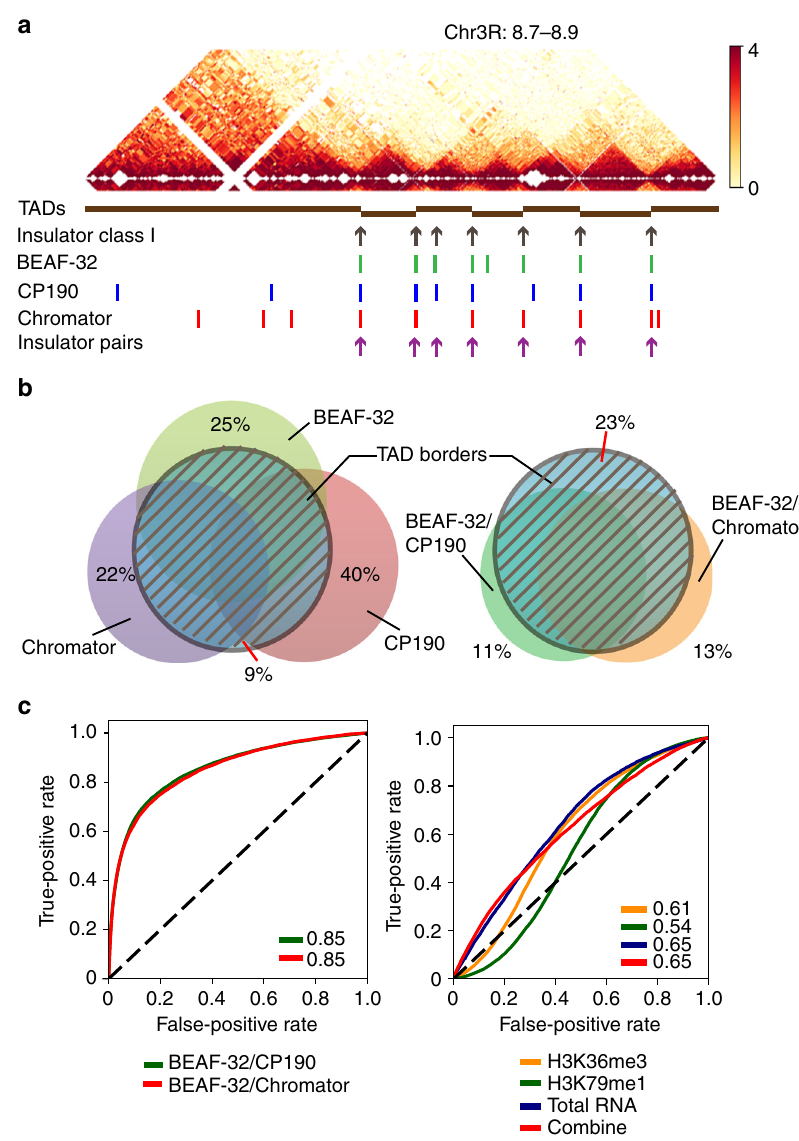
Fig. 2 The TADs are demarcated by pairs of insulator proteins. a The locations of known Drosophila insulator proteins, together with the TADs identi fi ed in this work, are shown for a 200 kb segment of chr3R. Shown are the positions of class I insulator proteins (that includes BEAF-32 and CP190), as obtained from Flybase, as well as the peak locations of the individual insulator proteins (BEAF-32, CP190, and Chromator) characterized in the modENCODE project. Also shown in the bottom row are the positions of the insulator protein pairs, BEAF-32/CP190, or BEAF-32/Chromator. b Venn diagram showing the genome-wide co-localization of these insulator proteins and insulator protein pairs at the TAD borders. c Logistic regression models to examine the predictive power of the insulator protein pairs (left panel) or transcriptionally active epigenetic modi fi cations or transcriptional levels (right panel) of TAD